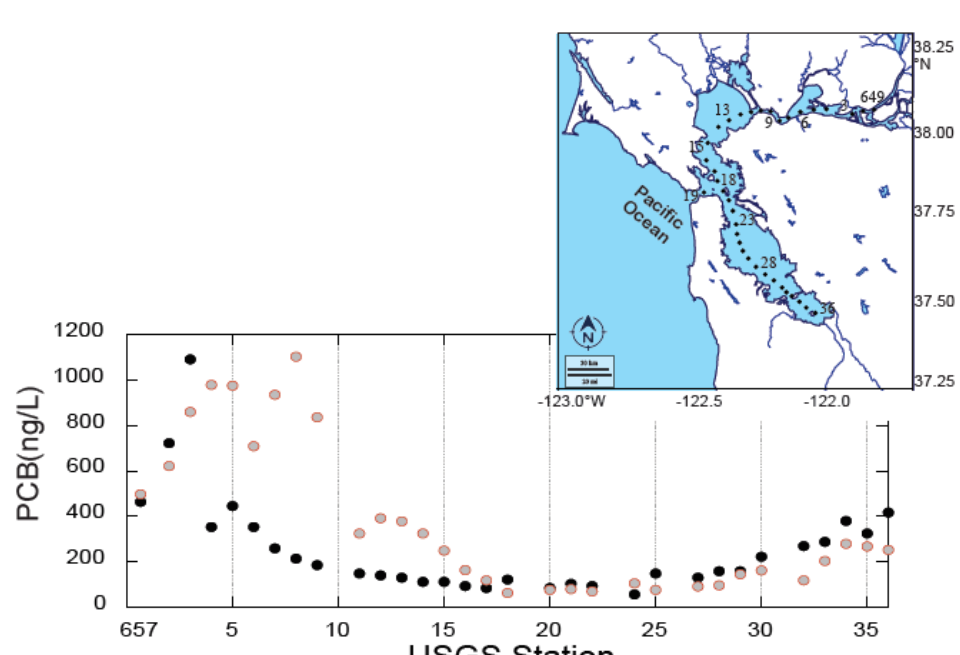
Figure 3. Comparison of PCB concentration estimated from a USGS cruise, collected 18 May 2016 (solid black), and an L8 OLI image, collected 26 May 2016 (grey). SSC values corresponding with the USGS stations were extracted from the image, converted to PCB values using the entire-bay model with zero intercept, and compared against PCB values estimated from the USGS cruise (by converting SSC to PCB values using the same algorithm).